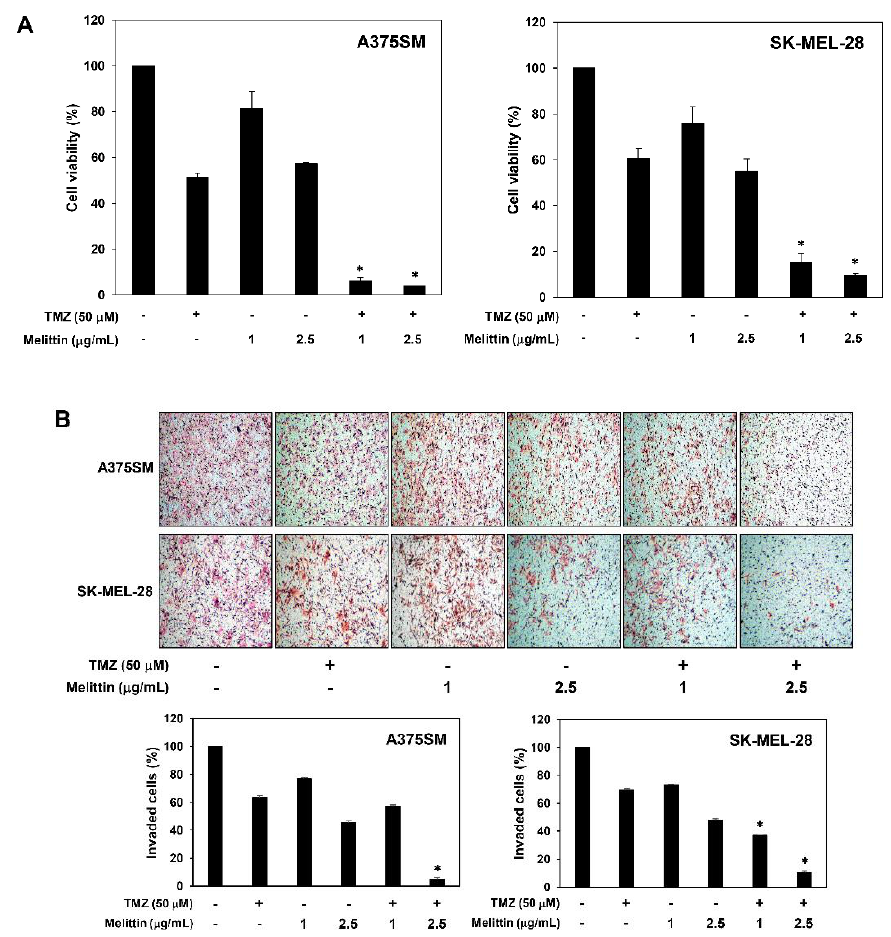
Figure 9. The effect of the combination of melittin with TMZ on the growth and invasion of melanoma cell lines. ( A ) Cells were treated with melittin and TMZ for 72 h, and cell growth was measured using the MTT colorimetric assay. ( B ) Cells were treated with melittin and TMZ for 24 h. Cells penetrating the Matrigel-coated polycarbonate filters were stained and counted under an optical microscope. * p < 0.05 versus the single agent treatment. Each value represents the mean ± SE from three independent